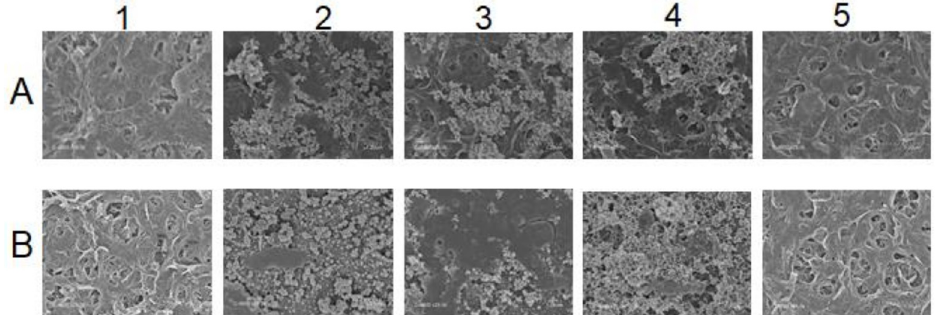
Figure 6. SEM of membrane surfaces at different states: ( A ) For membrane used in MBR effluent experiment, ( B ) Membrane used in SIS experiment. 1. Virgin membrane, 2. Fouled after experiment, 3. UPW-cleaned membrane, 4. Base-cleaned and 5.